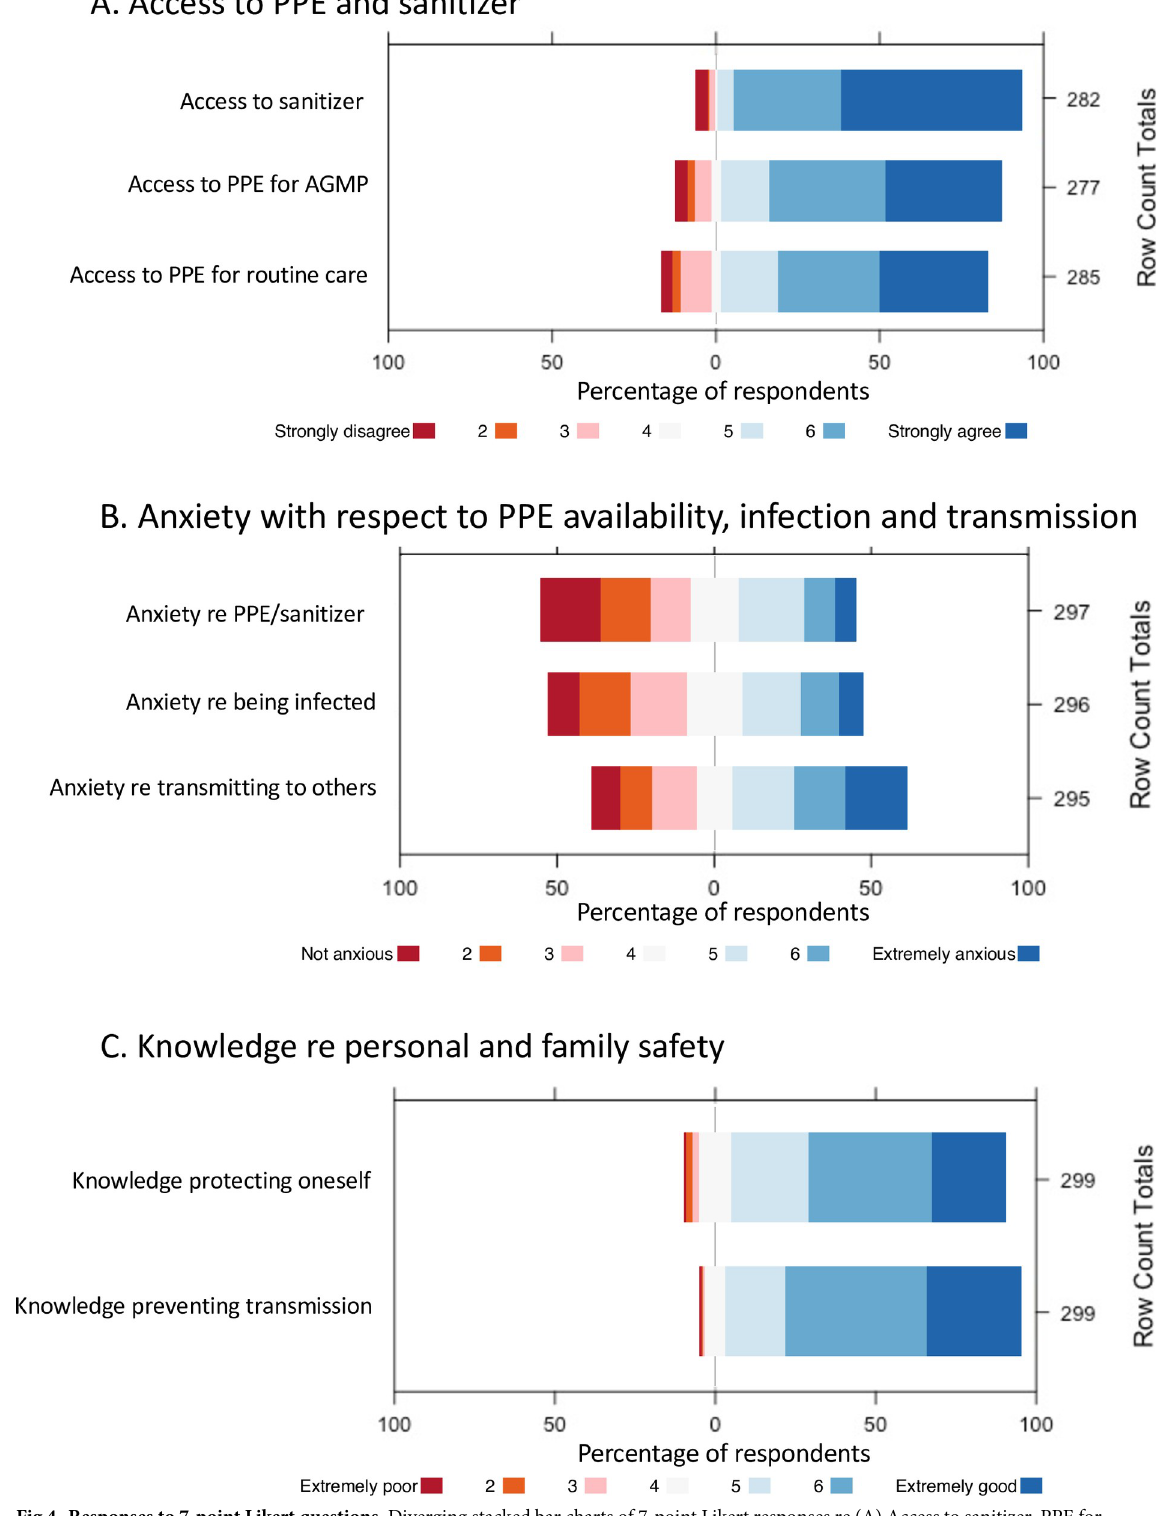
Fig 4. Responses to 7-point Likert questions. Diverging stacked bar charts of 7-point Likert responses re (A) Access to sanitizer, PPE for routine patient care and PPE for AGMP, (B) Anxiety with respect to PPE availability, risk of being infected with COVID-19, and risk